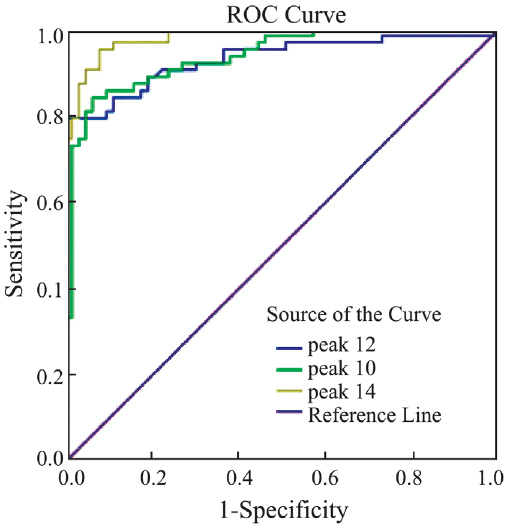
Figure 8. Receiver operated curves of peaks 10, 12 and 14.